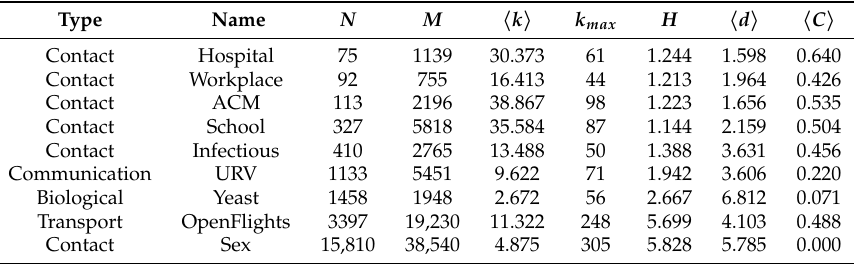
Table 3. Basic topological properties of nine various networks. Where N , M represent the number of nodes and edges, (cid:104) k (cid:105) and k max denote the average degree and maximum degree, H means index of degree heterogeneity, (cid:104) d (cid:105) is the mean shortest path length and (cid:104) C (cid:105) represents mean local clustering